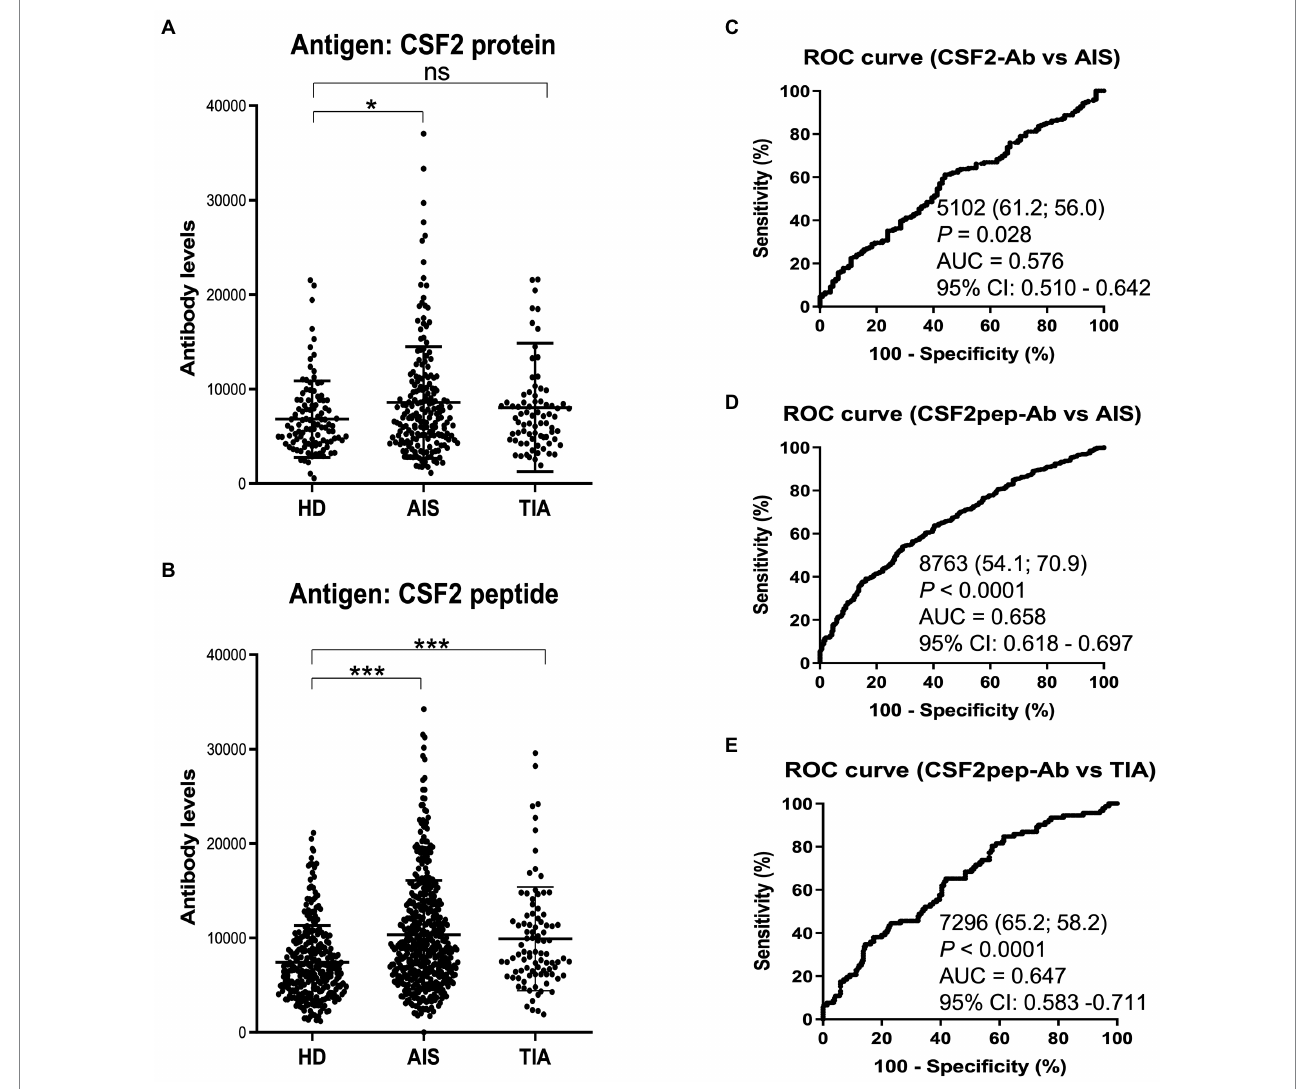
FIGURE 2 Comparison of the s-CSF2-Ab and s-CSF2pep-Ab levels in patients with AIS and TIA and in HDs. (A–B) Levels of serum antibodies against (A) s-CSF2-Ab and (B) s-CSF2pep-Ab determined using amplified luminescence proximity homogeneous assay-linked immunosorbent assay (AlphaLISA), calculated by subtracting the levels of antibodies against the control GST. Scatter dot plots of the s-CSF2-Ab and s-CSF2pep-Ab levels are also presented. Bars represent averages ± standard deviation (SD). ** P < 0.05; * P < 0.01; ns, not significant, Kruskal–Wallis test. (C–E) A receiver operating characteristic (ROC) curve analysis was conducted to assess the ability of s-CSF2-Ab to detect AIS (C) and that of s-CSF2pep-Ab to detect AIS (D) and TIA (E) . The numbers indicate the cutoff values for the indicated markers, and the numbers in parentheses indicate sensitivity (left) and specificity (right). The areas under the ROC curve (AUC) and 95% confidence intervals (CIs) are also shown. AIS, acute ischemic stroke; HD, healthy donor; CSF2-Ab, CSF2 antibody; CSF2pep-Ab, CSF2 peptide antibody; TIA, transient ischemic